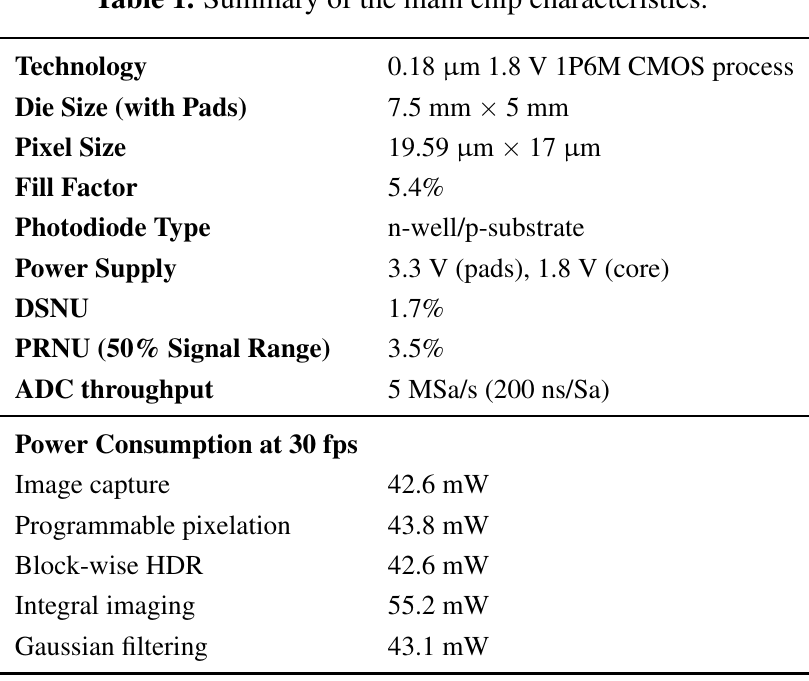
Table 1. A comparison with state-of-the-art focal-plane sensor-processor chips is presented in Table 2. Our prototype embeds the greatest functionality while featuring the largest resolution and the smallest pixel pitch, with a cost in terms of reduced fill factor. Table 1. Summary of the main chip